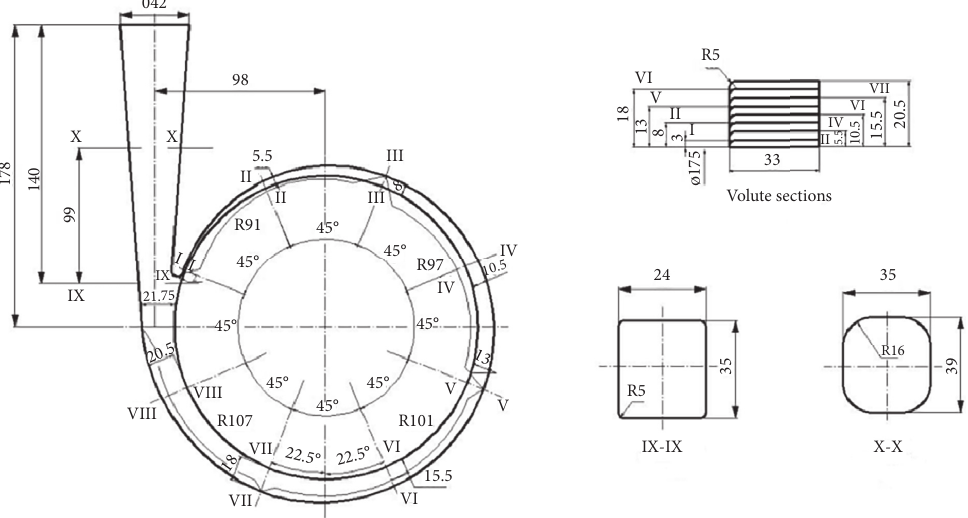
Figure 8: Two-dimensional diagram of the volute.